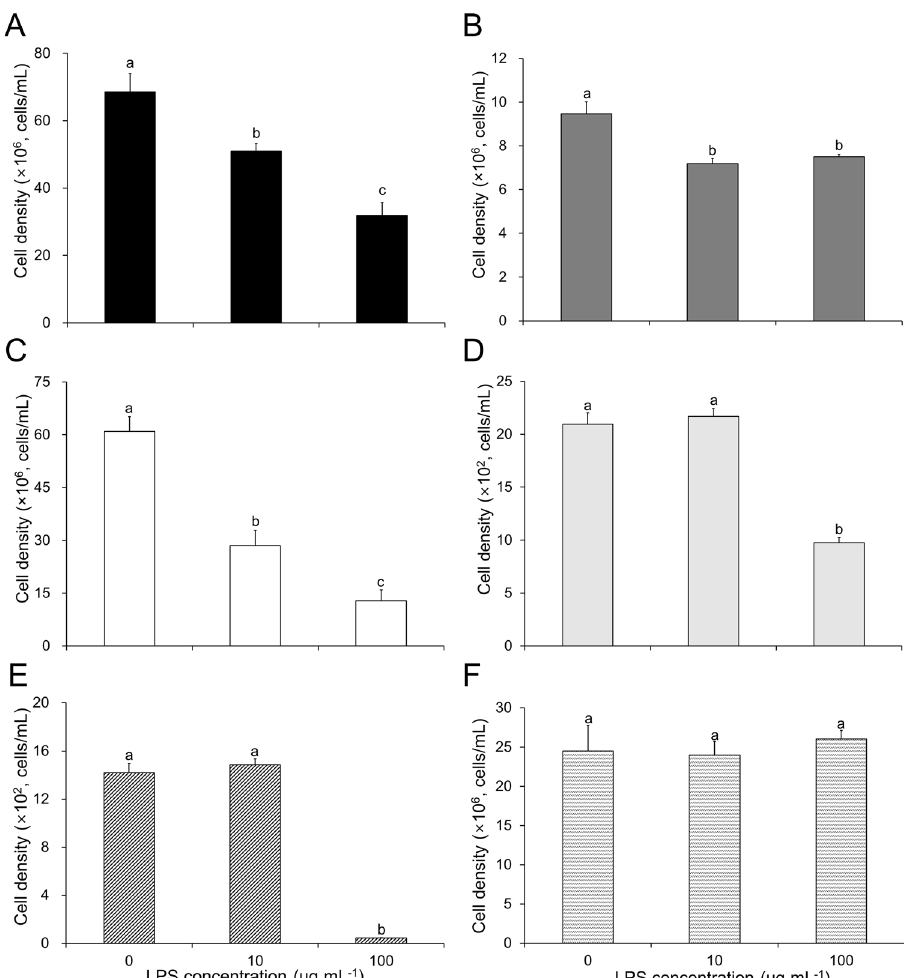
Figure 6. Effect of lipopolysaccharide (LPS) supplementation on the growth responses of various microalgae. ( A ) Chlorella sorikiniana , ( B ) Parachlorella kessleri , ( C ) Scenedesmus deserticola , ( D ) Alexandrium tamarense , ( E ) Cochlodinium polykricoides , ( F ) Microcystis aeruginosa . Error bars represent the mean ± standard deviation (SD) from triplicate experiments. Different letters represent significant difference ( P <